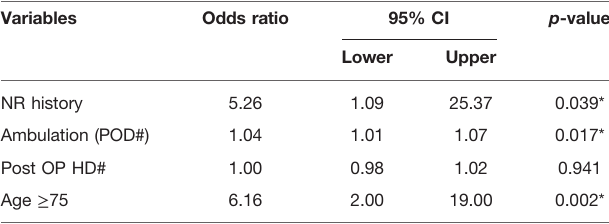
TABLE 3 | Multivariate analysis of factors predictive of delirium.